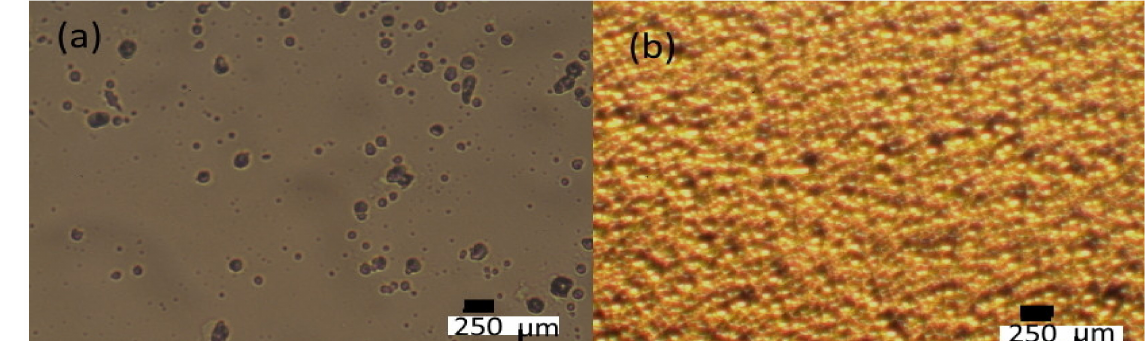
Figure 18. Optical micrographs of ( a ) a chinite and ( b ) Darwin glass.